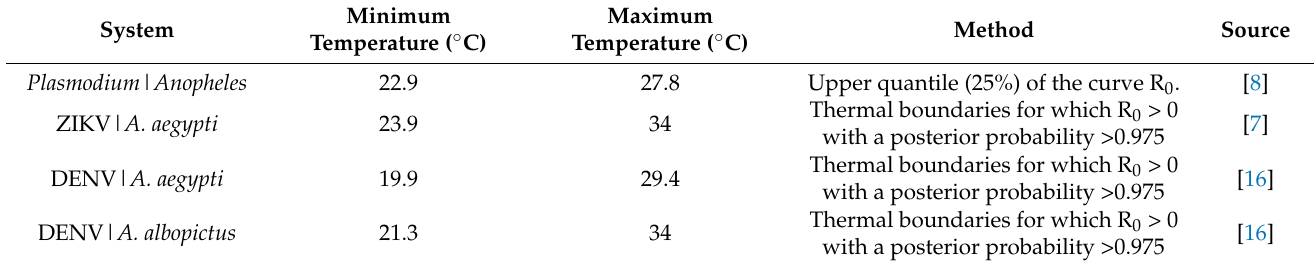
Table 1. Thermal limits for the four disease vectors considered in this paper, compiled from Ryan et al.